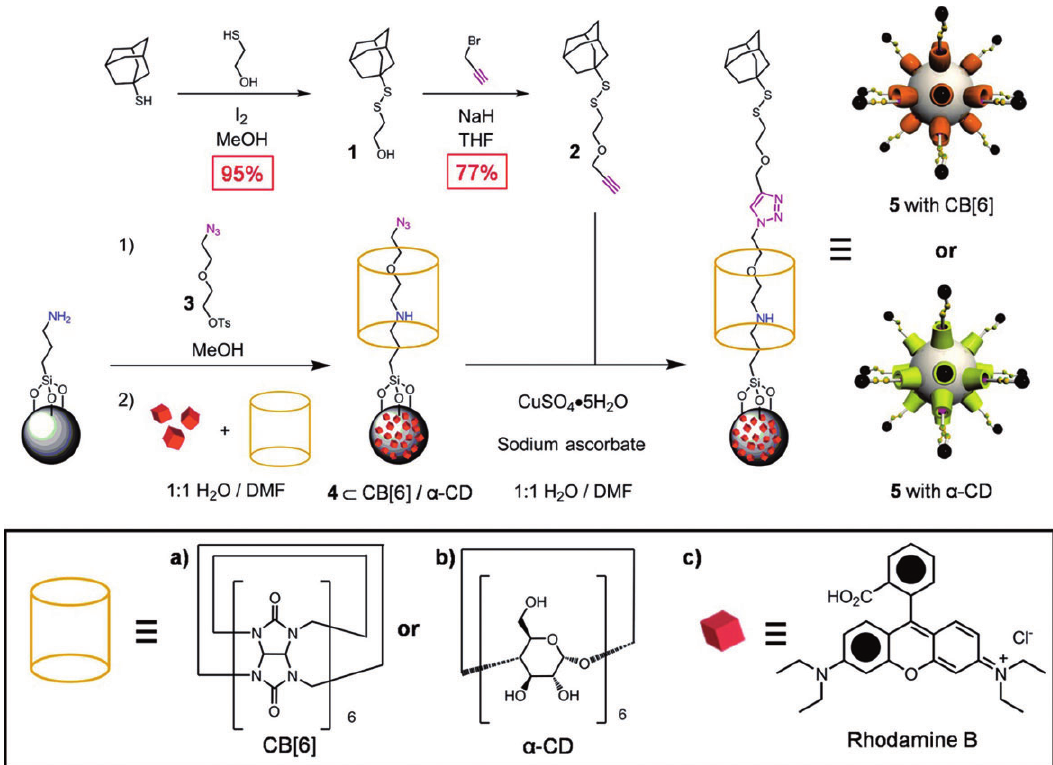
Figure 11 Synthesis of the alkyne-terminated stopper and assembly of disulfi de-based snap-top nanocarriers [55] . Reprinted with permission from Ref. [55] . Copyright (2010) American Chemical